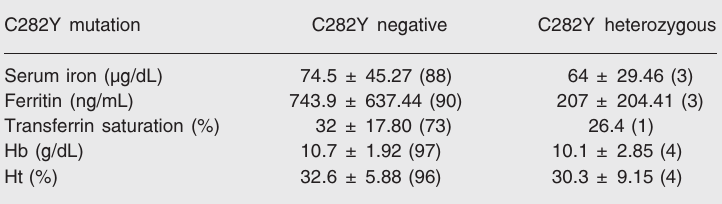
Table 1. Biochemical parameters of 118 patients with chronic renal insufficiency, classified by C282Y genotype in the HFE gene.